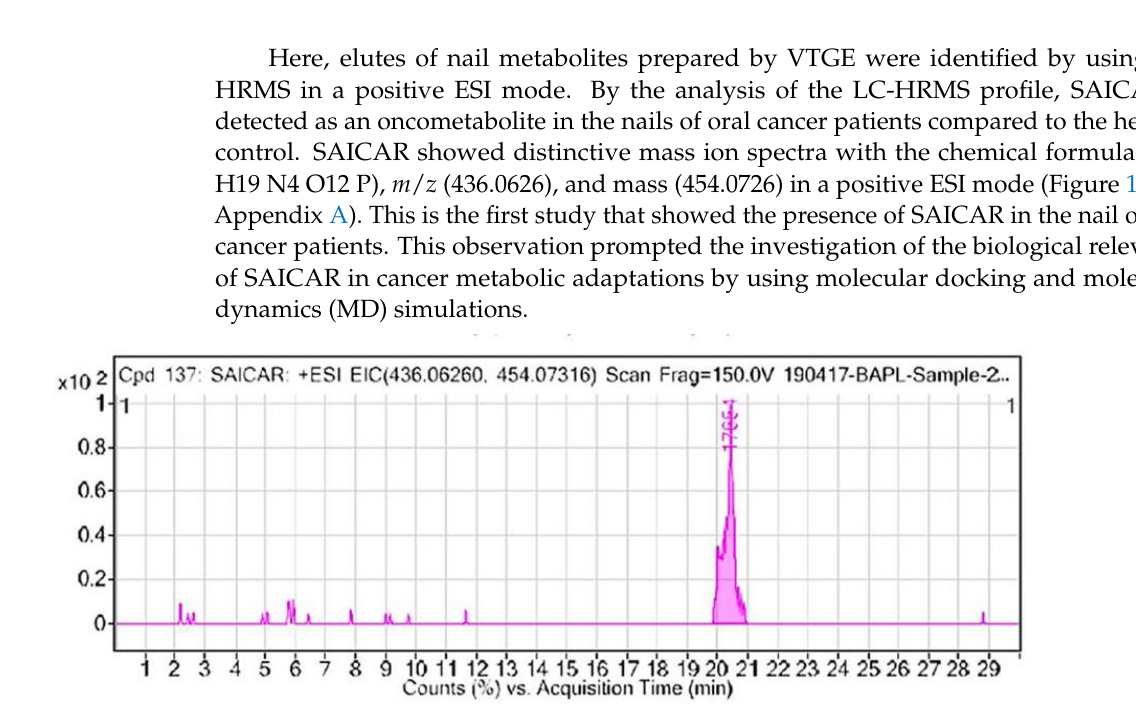
Figure 1. An oncometabolite SAICAR is detected in nails of oral cancer patients. A positive ESI extracted ion chromatogram (EIC) of SAICAR was detected during LC-HRMS of nail lysates purified with the help of a novel VTGE tool.